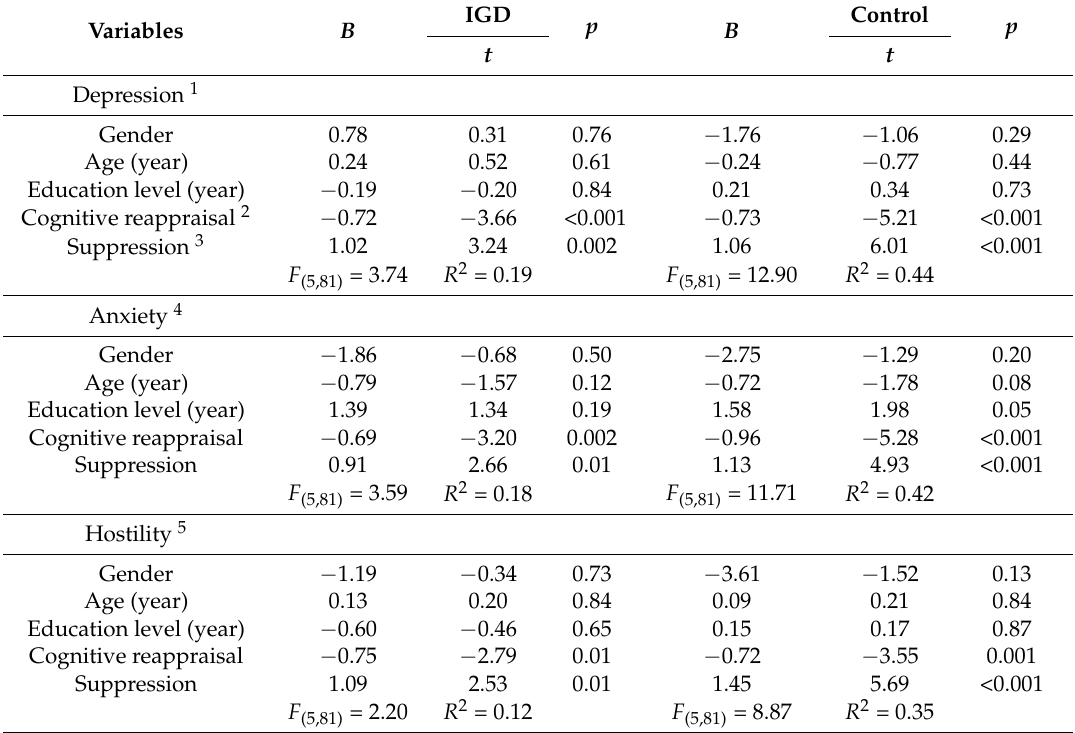
Table 3. Multiple linear regression analysis for the predictive value of emotional regulation in depression, hostility, and CGI score among IGD group or control